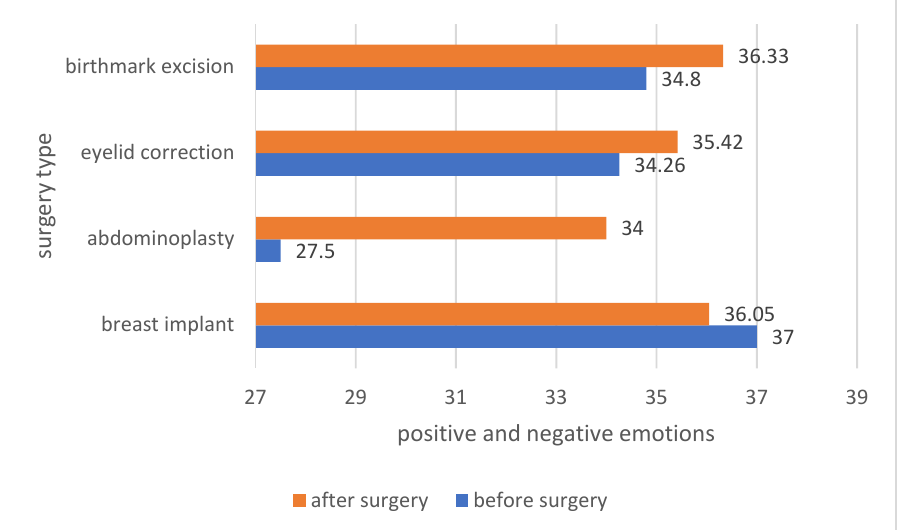
Figure 9. Positive and negative emotions felt among patients before and after the procedure.